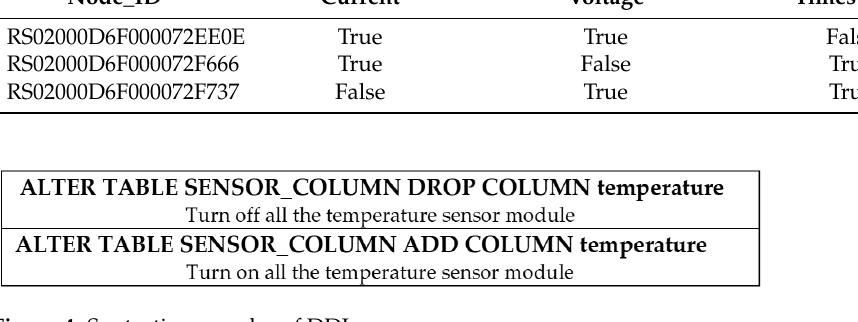
Figure 4. Syntactic examples of DDL. Table 2. SENSOR_COLUMN table.